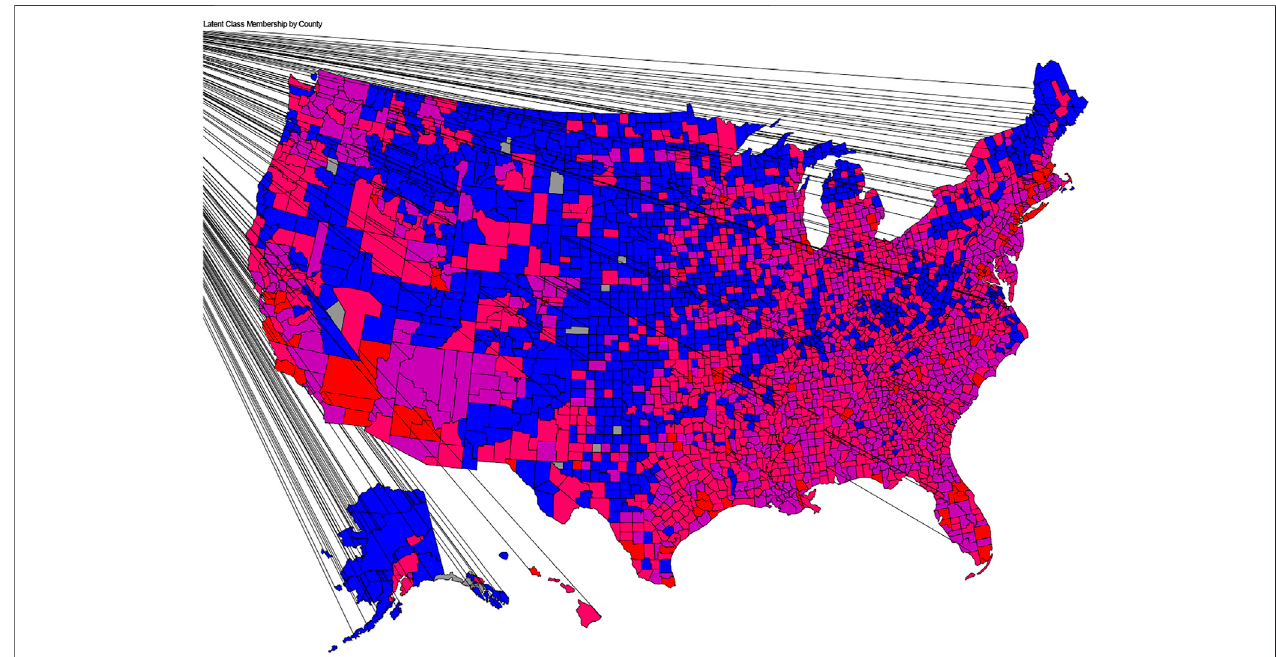
FIGURE 1 | Map of Latent Class membership by